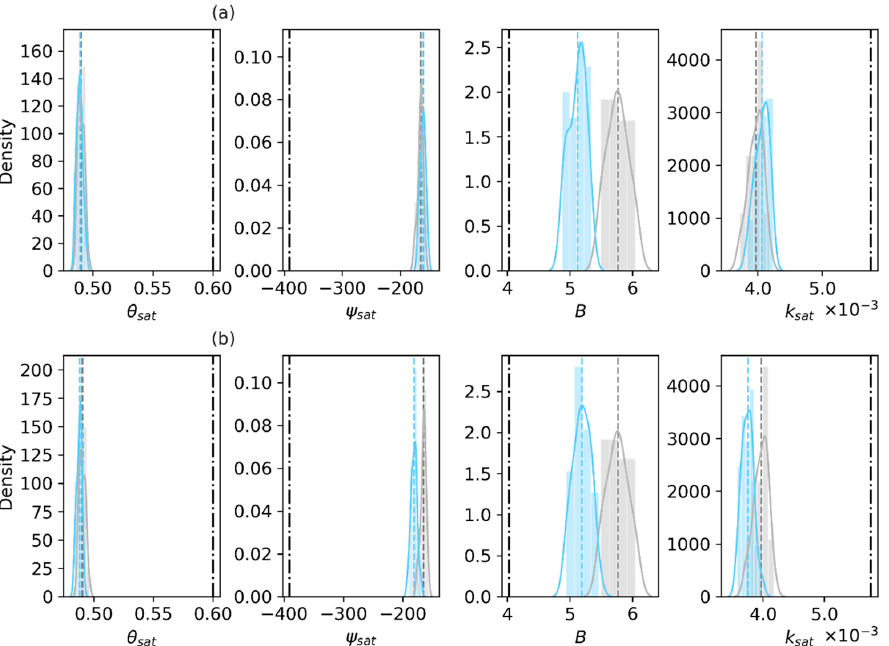
Figure 5. Prior and posterior distributions of the soil hydraulic parameters at 2.79 cm, with the truth based on laboratory measurements of the 0–5 cm soil layer sampled in the field. Gray shows the prior, light blue indicates the posterior, and the black dash-dotted line indicates the laboratory measurements. ( a ) Only_Para and ( b ) Joint_Updt experiments with SMAP T H assimilation. The hydraulic parameters are the saturated soil moisture content θ sat (m 3 /m 3 ), saturated matric potential ψ sat (mm), the pore size distribution index B (dimensionless) and saturated hydraulic conductivity k sat (mm/s).